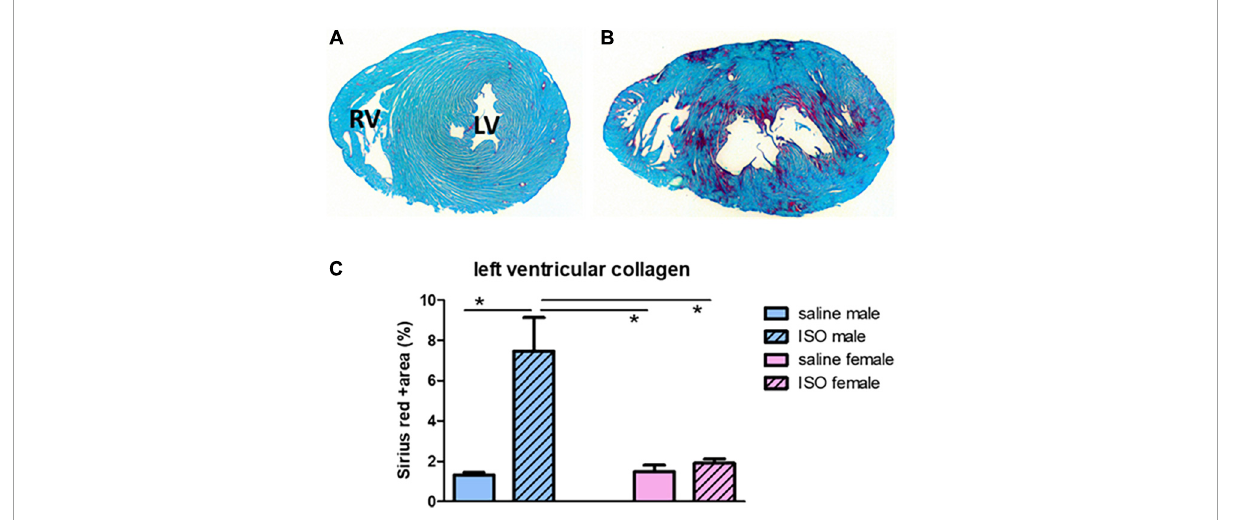
FIGURE2 Illustration of transversal sections of the heart with Sirius red staining of cardiac collagen. Upper part shows the result of collagen staining (red) in a saline treated male rat (A) and an ISO treated male rat (B) . LV, left ventricle; RV, right ventricle. Lower graph (C) actual measurements of collagen percentage in the different experimental groups. ISO, isoproterenol. *Significant difference between indicated groups ( p < 0.05).